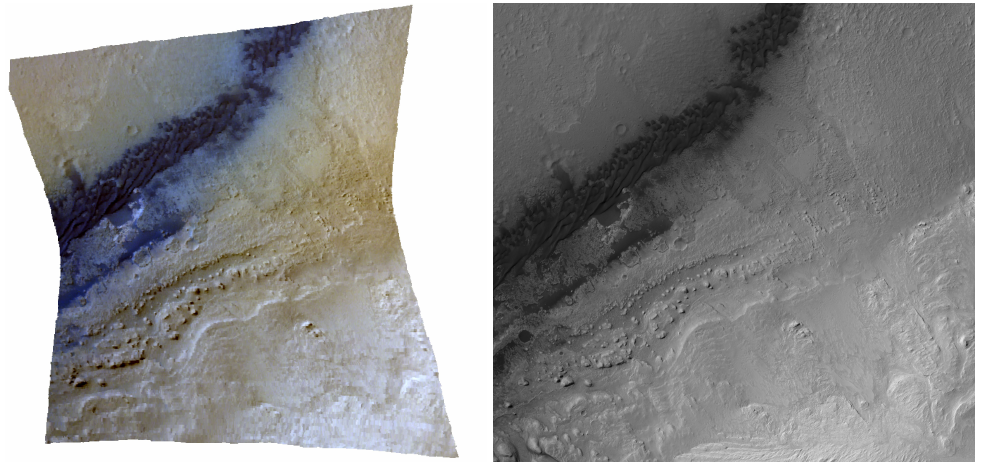
Figure 3. Enhanced visible color image of CRISM observation FRT0000C518 ( left ) and corresponding cut-out of CTX B01_009861_1753 ( right